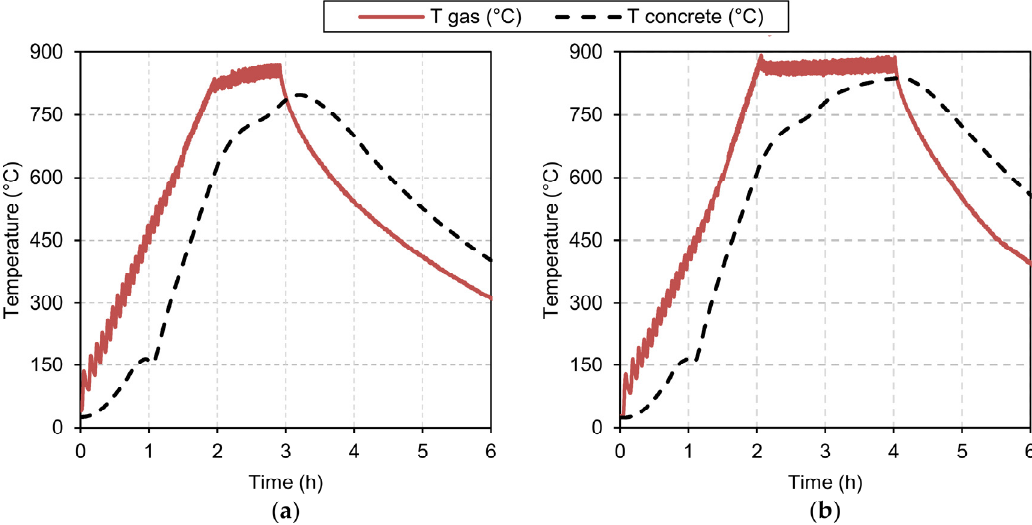
Figure 1. Time evolution of temperature during heating process: ( a ) thermal saturation during 1 hour; ( b ) thermal saturation during 2 hours.